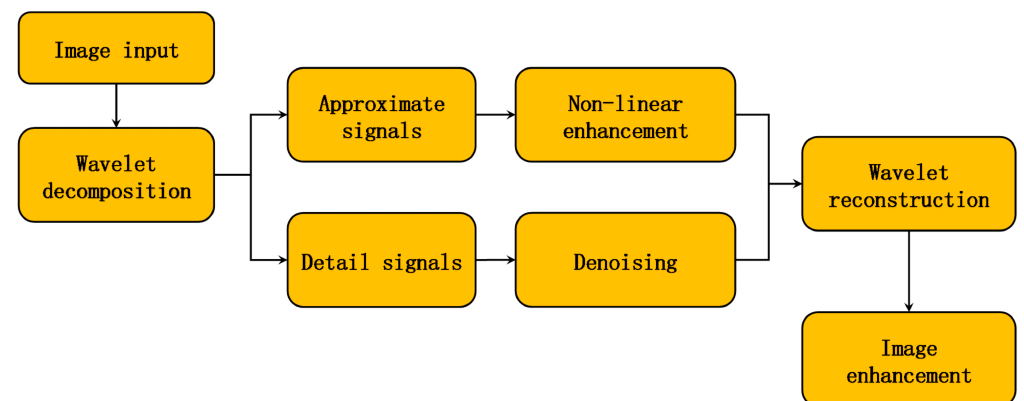
Figure 4. Image enhancement process.